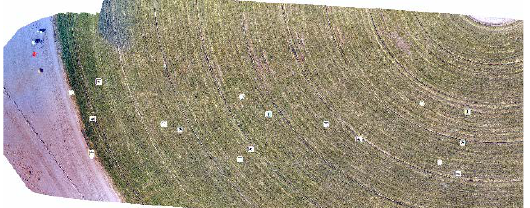
Figure 2 – Test site showing layout of GCPs at Todhia